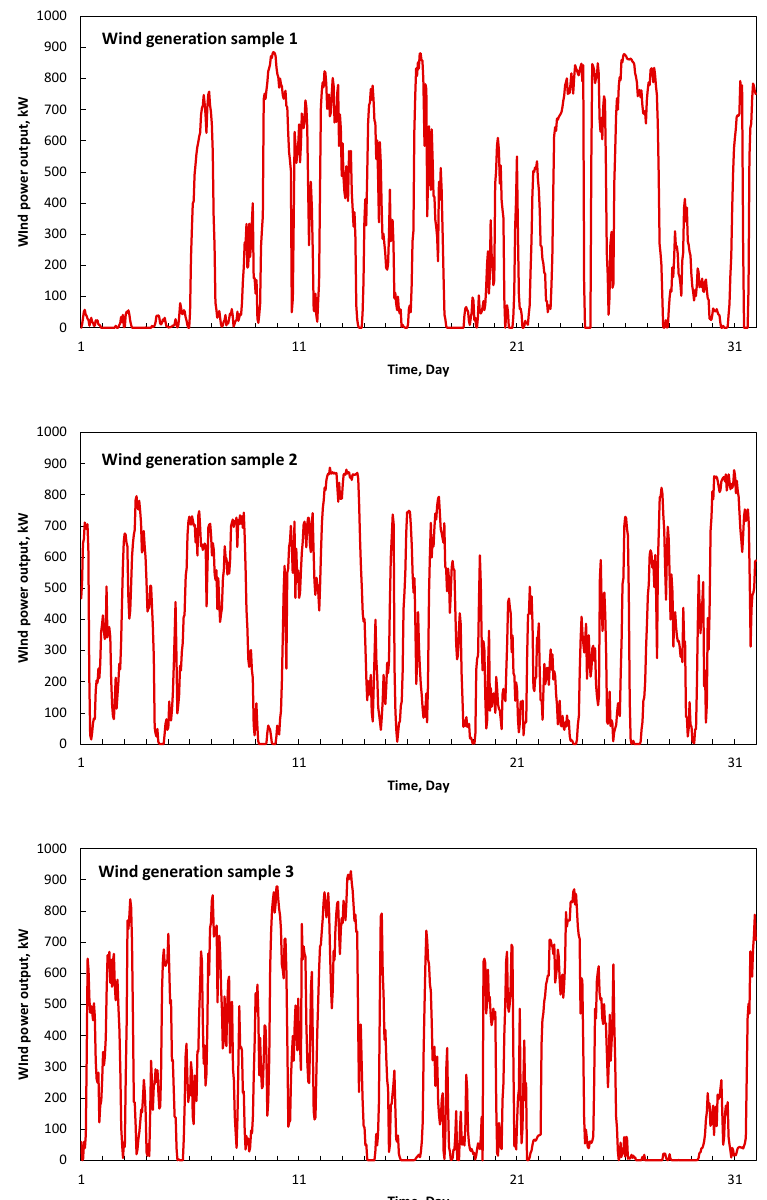
Figure 3. Time series plots of three wind power generation samples. Table 4. Estimated parameters and performance measures for the first wind generation sample.